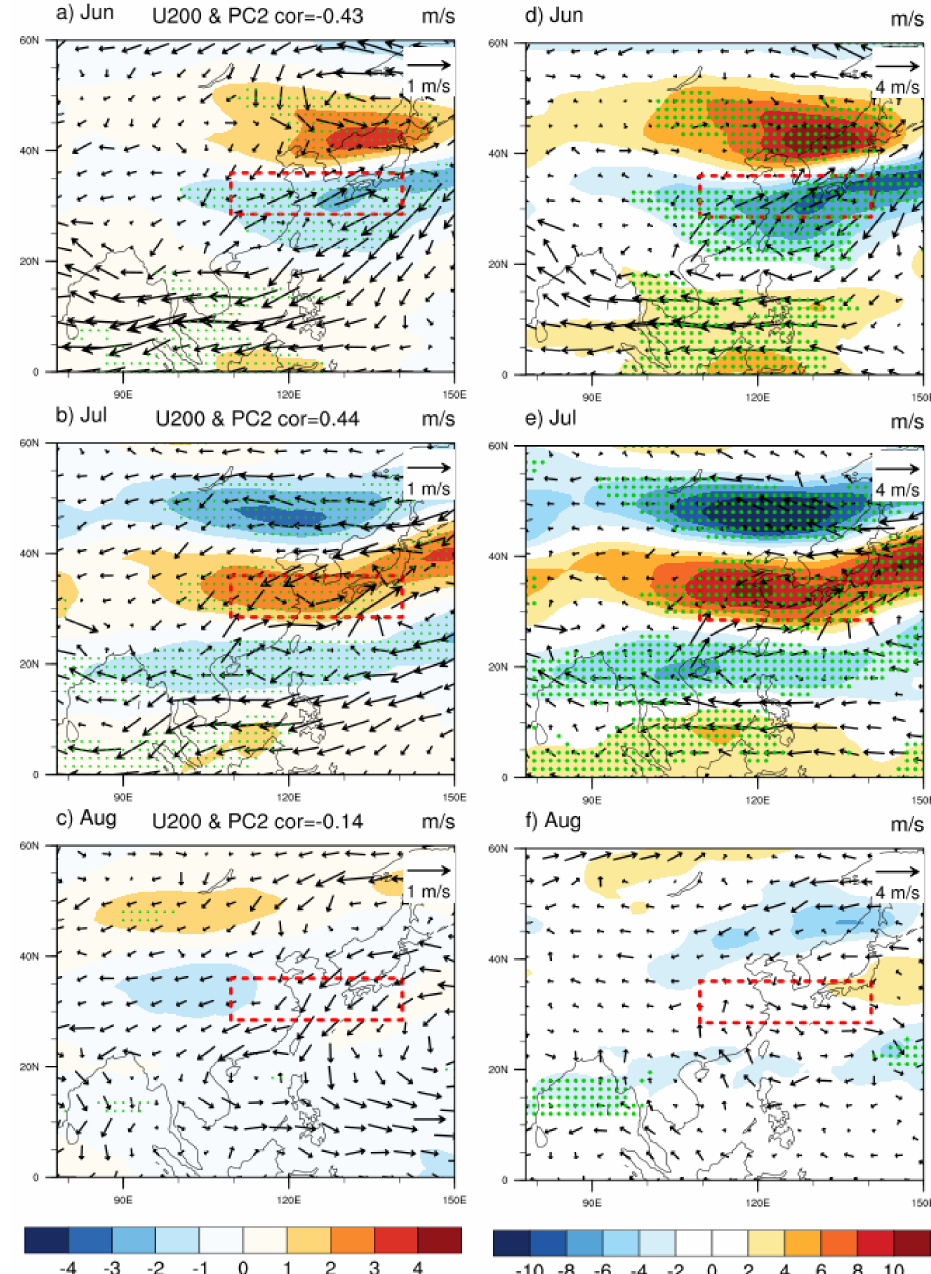
Figure 9. Same as Figure 6 but for PC2. Regression maps are ( a – c ) and difference maps are ( d – f